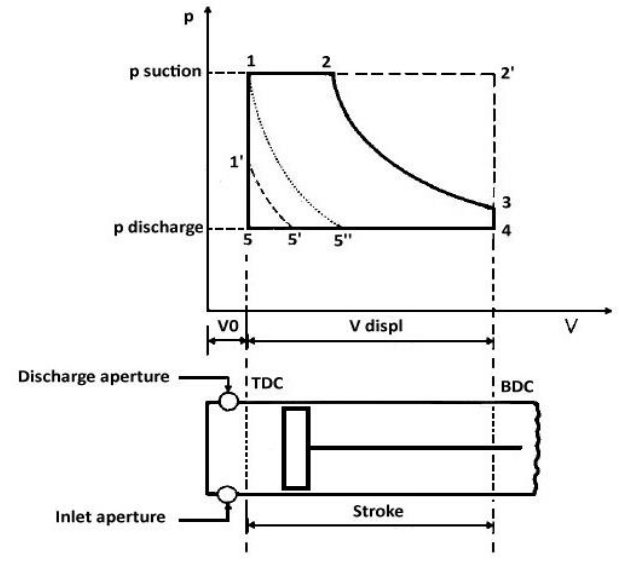
Figure 1. Pressure – volume diagram of a piston expander. Figure 1. Pressure–volume diagram of a piston